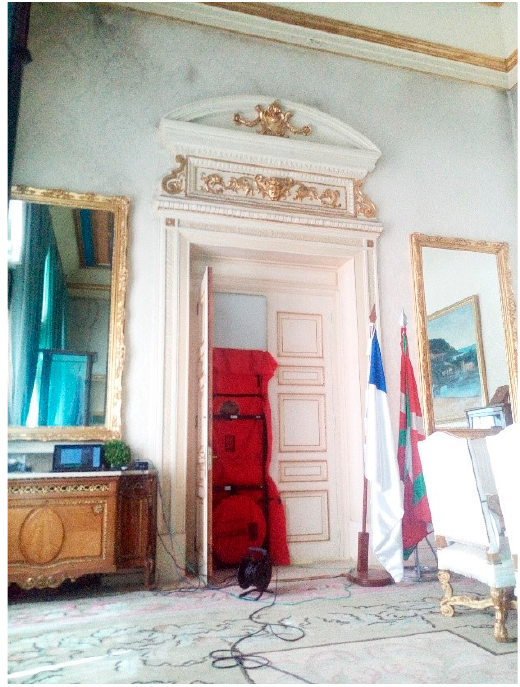
Figure 4. Use of the Minneapolis BlowerDoor equipment in the 31.F sample of the City Council building of Donostia-San Sebastián.